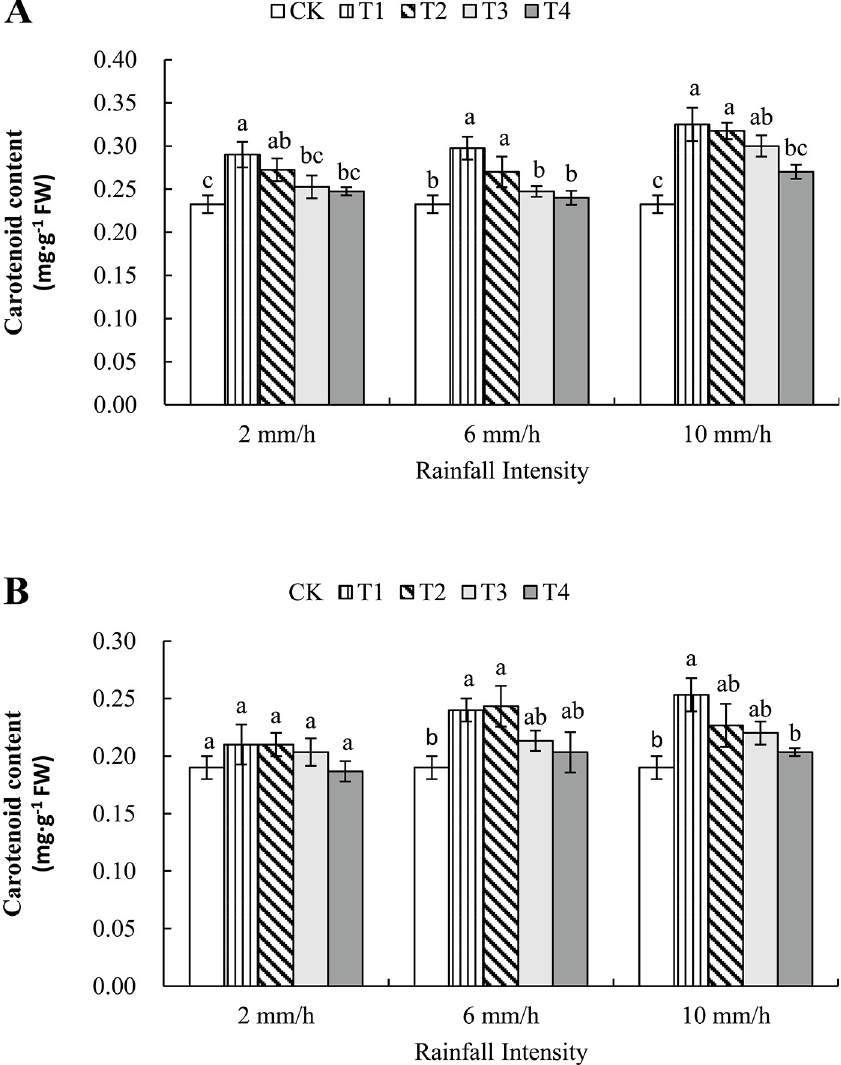
Fig 1. Effect of simulated rainfall on carotenoid content in leaves of C . album treated by mesotrione after 3 (A) and 6 (B) DAT. X-axis represents different rainfall intensity; y-axis represents the carotenoid content of leaves. CK means that there was no rain after the application of mesotrione, T1, T2, T3, and T4 represent different rainfall interval times (0.5 h, 1 h, 2 h, and 4 h). Effect of simulated rainfall on carotenoid content in leaves of C . album treated by mesotrione after 3 DAT (A) and 6 DAT (B). Lowercase letters in the same column indicate significant differences at the 0.05 level.